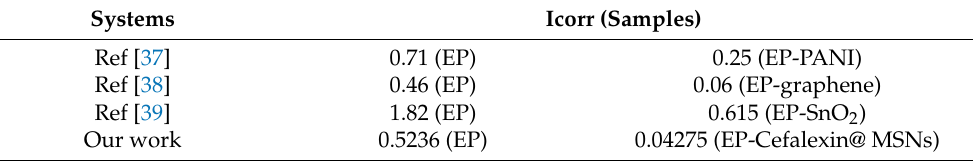
Table 5. The Icorr of different coatings on 304 SS in 3.5 wt.% NaCl solution ( µ A/cm 2